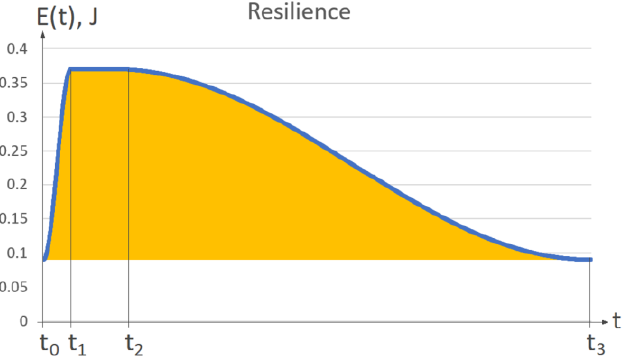
Figure 24. Resilience with simulated